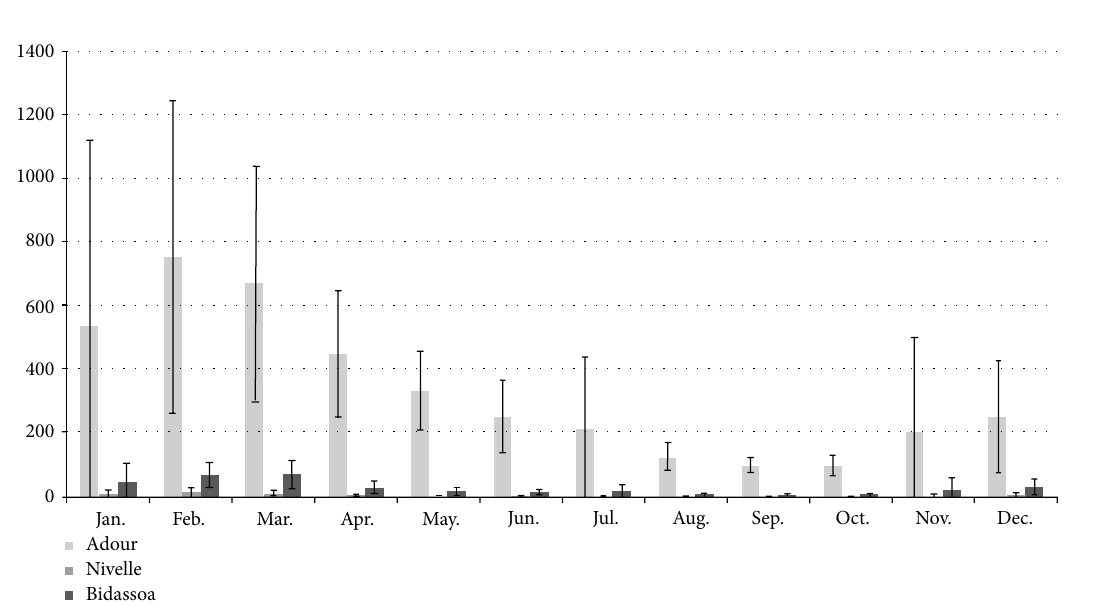
Figure 3: Mean monthly river discharge (m 3 ·s −1 ) for the three exposed sites: Adour, Nivelle and Bidassoa Rivers. The error bars represent the standard deviation for each month during the eight sampling